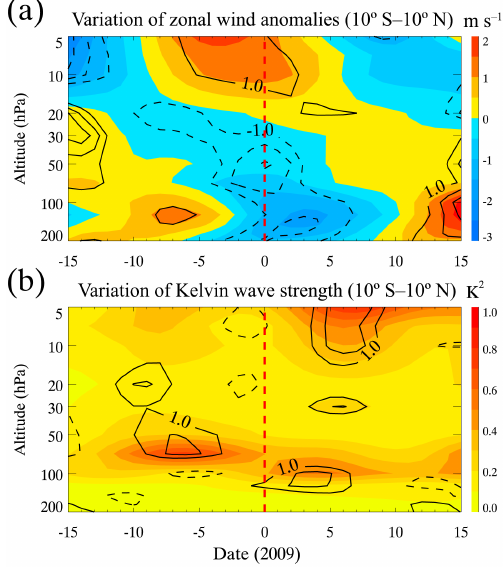
Figure 5. The time–altitude cross section of (a) the anomalous zonal mean zonal wind averaged between 10 ◦ S and 10 ◦ N, and (b) the strength of Kelvin waves averaged between 10 ◦ S and 10 ◦ N. The red vertical lines indicate day 0 (22 January), the central date of the 2009 SSW event. All of the variables above are presented both in physical value (color shades) and anomalous values normalized by standard deviations (black contours). Solid contours indicate posi- tive values of normalized anomalous values while dashed contours indicate negative